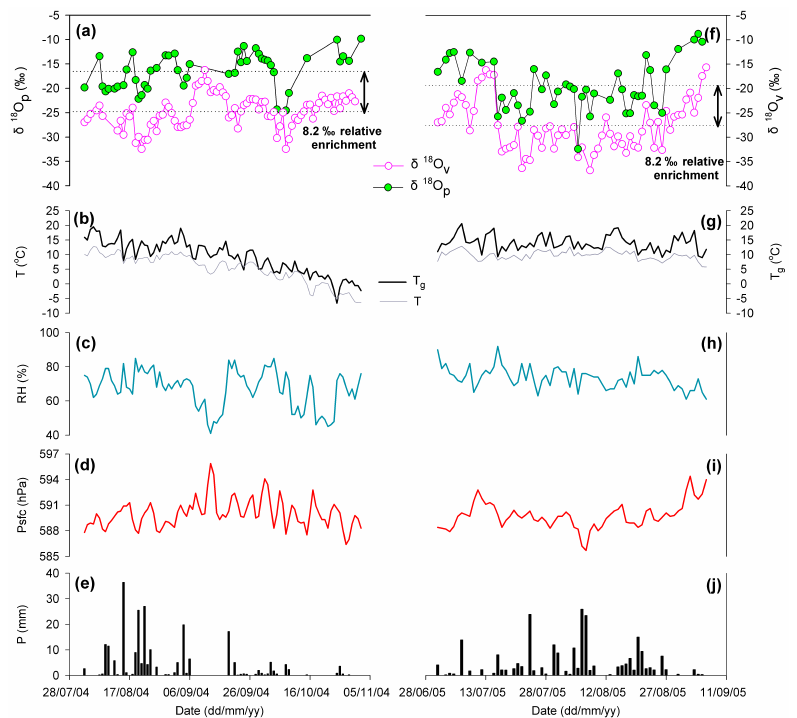
Figure 2. Daily variations of δ 18 O in water vapour ( δ 18 O v ) and precipitation ( δ 18 O p ) (a , f) , temperature at 1.5m ( T ) and temperature near ground (at 0m, T g ) (b , g) , relative humidity (RH) (c , h) , surface pressure (Psfc) (d , i) , and precipitation amount ( P ) (e , j) at Nagqu over the entire sampling period of